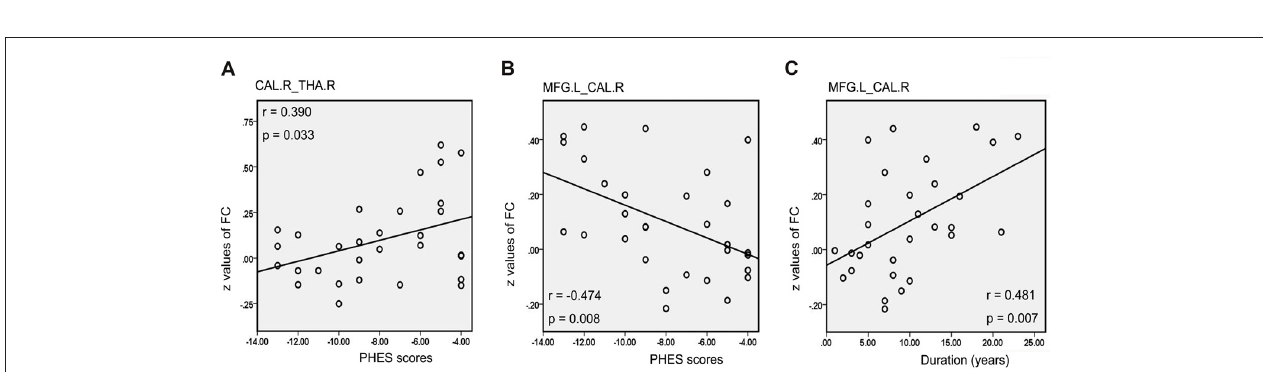
FIGURE 5 | Correlation between abnormal regional homogeneity (ReHo) and clinical variables in cirrhotic patients with and without MHE. Panel (A) depicts mean ReHo in the right fusiform gyrus (FFG.R), which was positively correlated with the disease duration of patients with MHE; panel (B) shows mean ReHo in the right frontal pole, which was positively correlated with the disease duration in the patients without MHE (NMHE); panel (C) depicts negative correlations between mean ReHo in the right frontal pole and psychometric hepatic encephalopathy scores (PHES) in the NMHE group. The threshold was set p < 0.05 without multiple comparison correction.